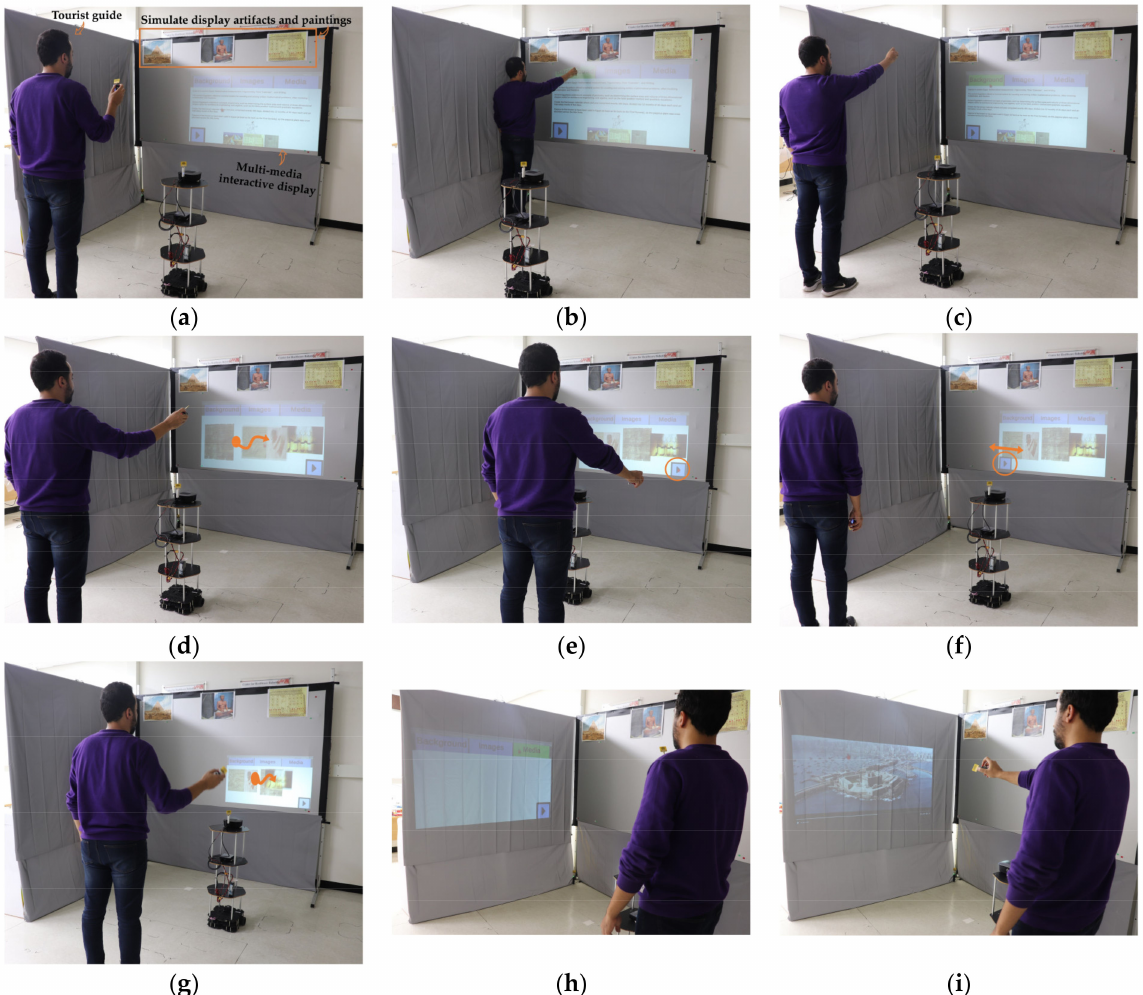
Figure 16. Simulation of a museum’s interactive multimedia display to support showcases of on-display artifacts: ( a ) Simu- lated museum environment setup, ( b ) close interaction, ( c ) distance interaction, ( d ) perform drag and drop, ( e ) accurate pointing, ( f ) graphics follow user’s position, ( g ) interact with customized small size screen, ( h ) replicate interactions with other walls, and ( i ) control video